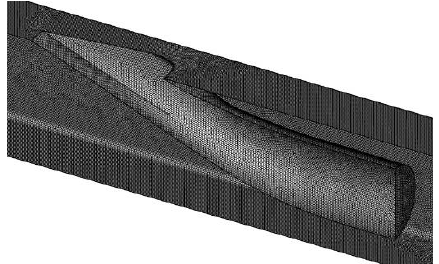
Figure 9. Local mesh of missile body surface and inlet.